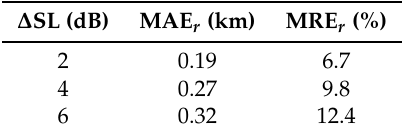
Table 4. MAE r and MRE r comparison when two SLs are different on HCA.